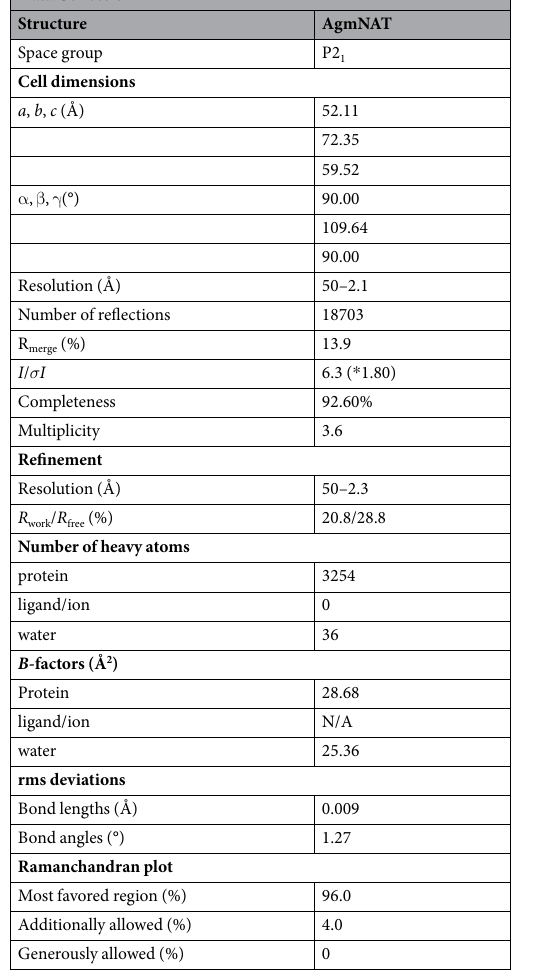
Table 1. X-ray Data Collection and Refinement Statistics for AgmNAT. * Value denotes highest resolution shell (2.3